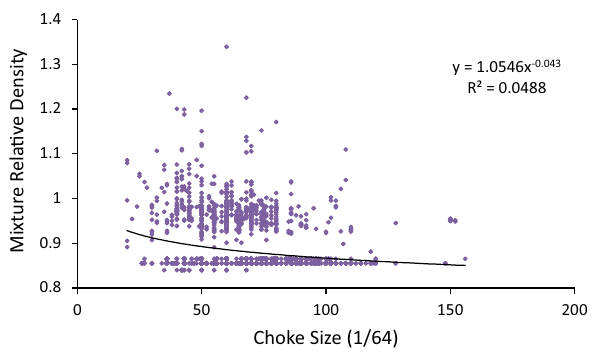
Fig. 4 Mixture relative density versus choke size of the raw data